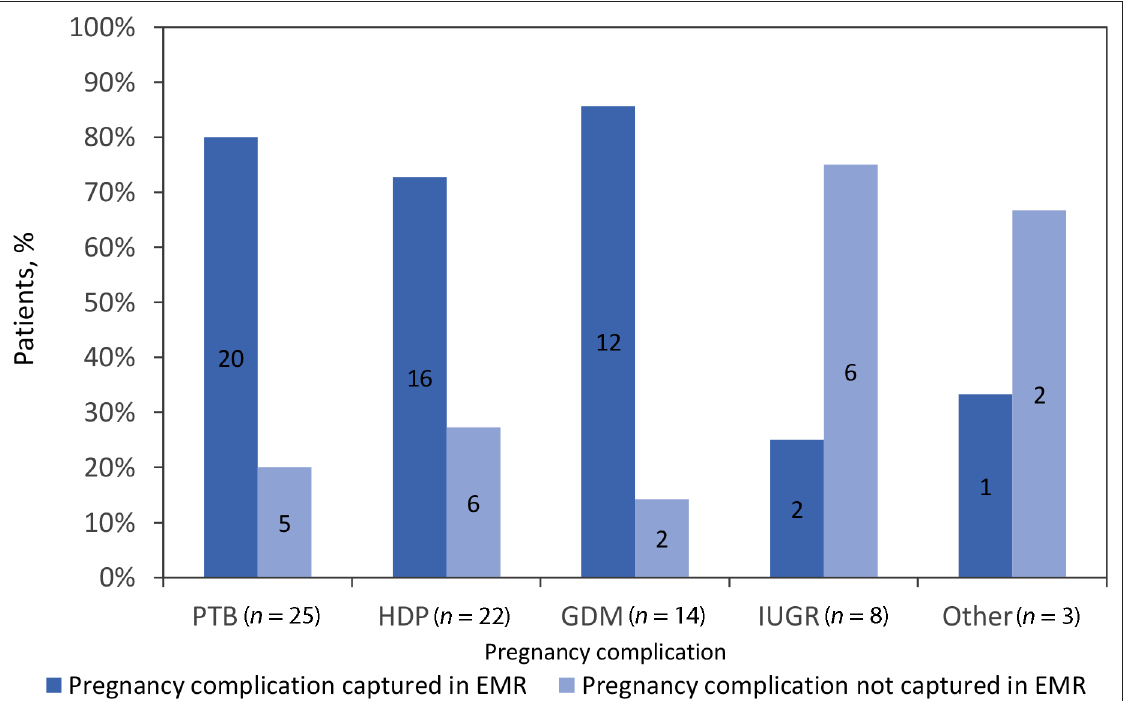
Figure 4 Documentation of pregnancy complications according to type of pregnancy complication. GDM = gestational diabetes mellitus. HDP = hypertensive disorders of pregnancy. IUGR = intrauterine growth restriction. PTB = preterm birth.